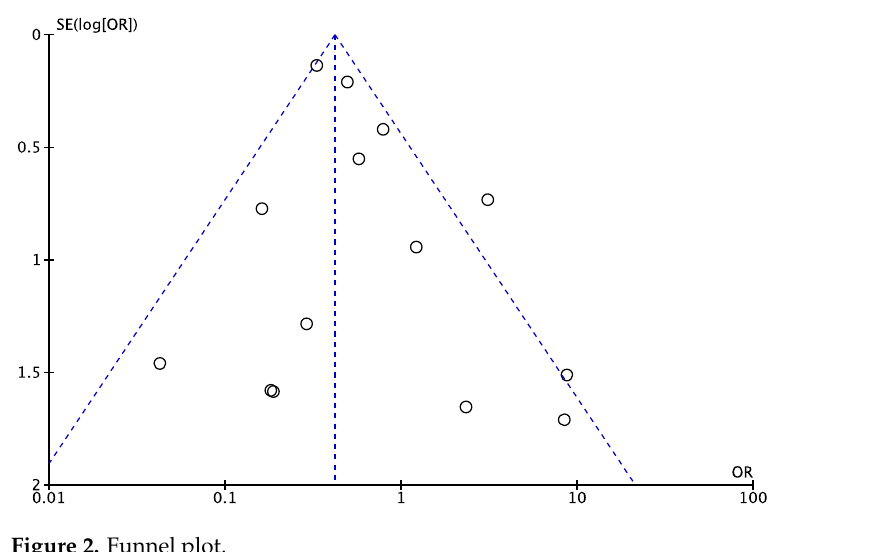
Figure 2. Funnel plot. Table 2. Methodological quality